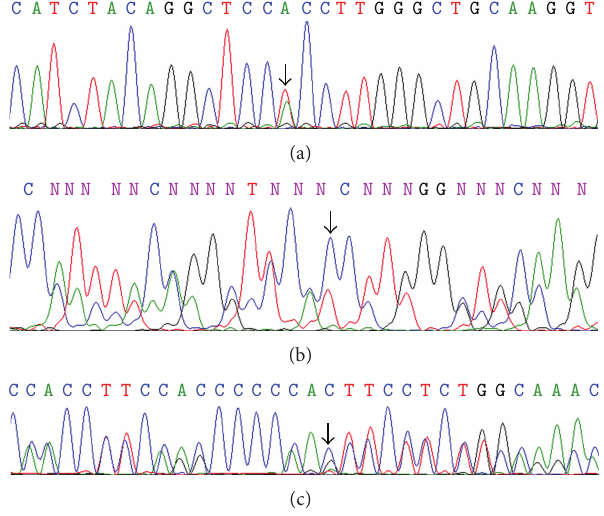
Figure 1: Representative electropherograms of the mutations found in the patient. The mutations are shown by arrows. (a) g.185A > T (p.H62L) mutation. (b) Reverse complement electropherogram showing the deduced presence of g.185A > T (p.H62L) on the allele carrying the g.562 568delG polymorphism. (c) IVS2-13 A/C > G mutation on the homologous